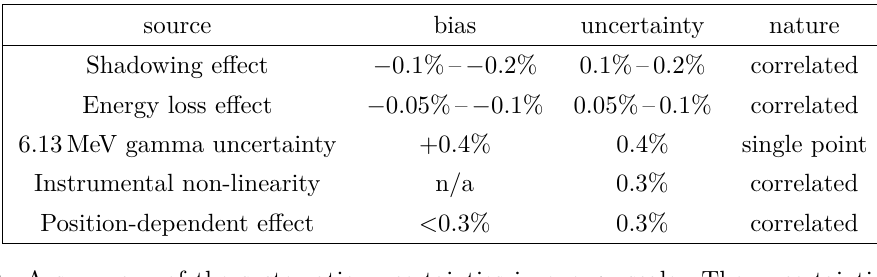
Table 2 . A summary of the systematic uncertainties in energy scale. The uncertainties are set equal to the absolute values of the bias for conservativeness. The last column indicates whether this uncertainty is correlated among different sources or energy, or should only be applied to a single